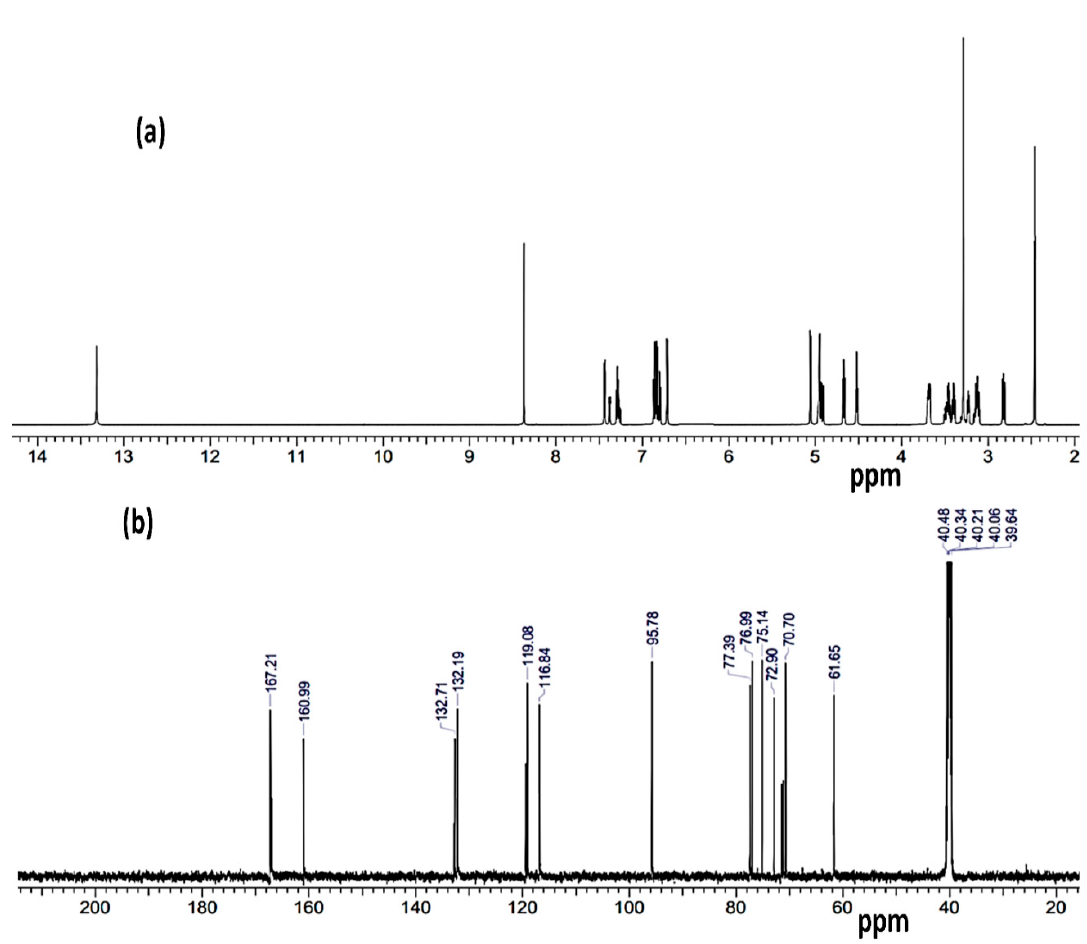
Figure 7. ( a ) 1 H, ( b ) 13 C-NMR of GASB-1 dissolved in